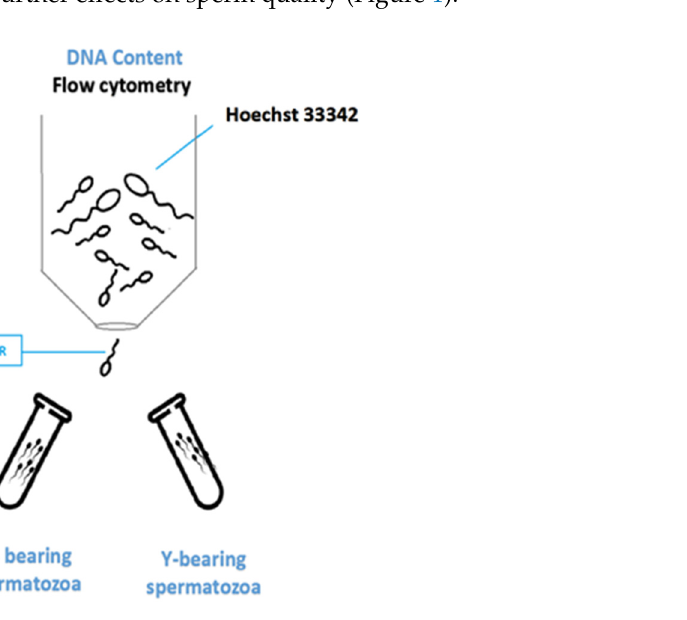
Figure 1. Schematic representation of conventional sex-sorting technique (Flow cytometry).